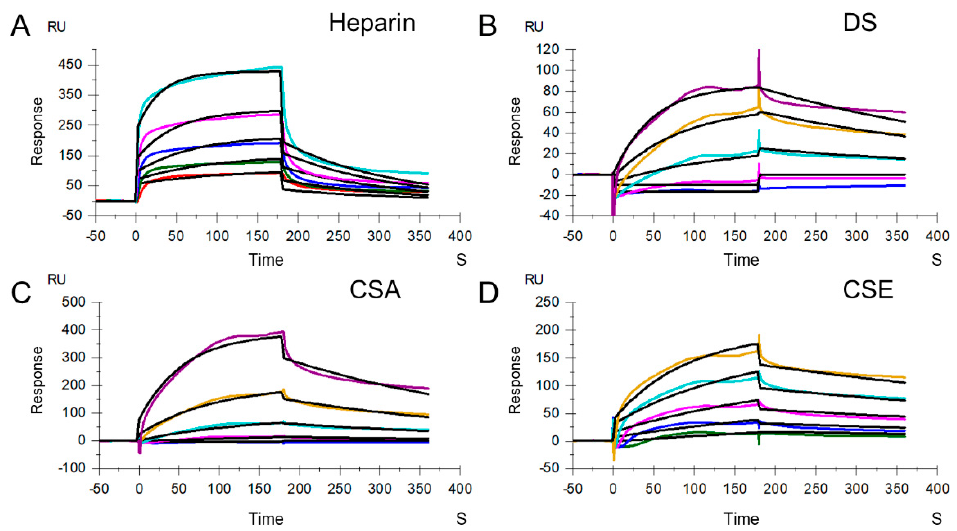
Figure 3. SPR sensorgrams of MPXV A29 binding with GAGs. ( A ) SPR sensorgrams of MPXV A29 binding with heparin. Concentrations of MPXV A29 (from top to bottom) are 1000, 500, 250, 125, and 63 nM, respectively. ( B ) SPR sensorgrams of MPXV A29 binding with DS. Concentrations of MPXV A29 (from top to bottom) are 4000, 2000, 1000, 500, and 250 nM, respectively. ( C ) SPR sensorgrams of MPXV A29 binding with CSA. Concentrations of MPXV A29 (from top to bottom) are 4000, 2000, 1000, 500, and 250 nM, respectively. ( D ) SPR sensorgrams of MPXV A29 binding with CSE. Concentrations of MPXV A29 (from top to bottom) are 2000, 1000, 500, 250, and 125 nM, respectively. The black curves are the fits using models from T200 Evaluate software 3.2. Table 2. Summary of kinetic data of MPXV A29 binding with heparin, DS, CSA, and